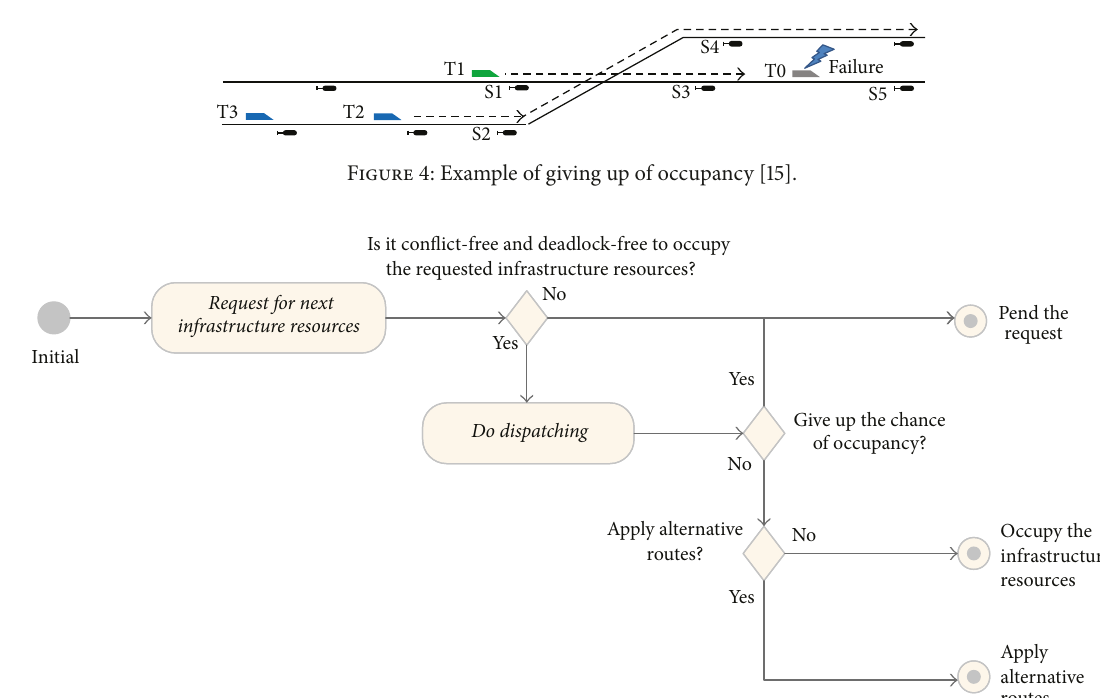
Figure 5: The dispatching mechanism in